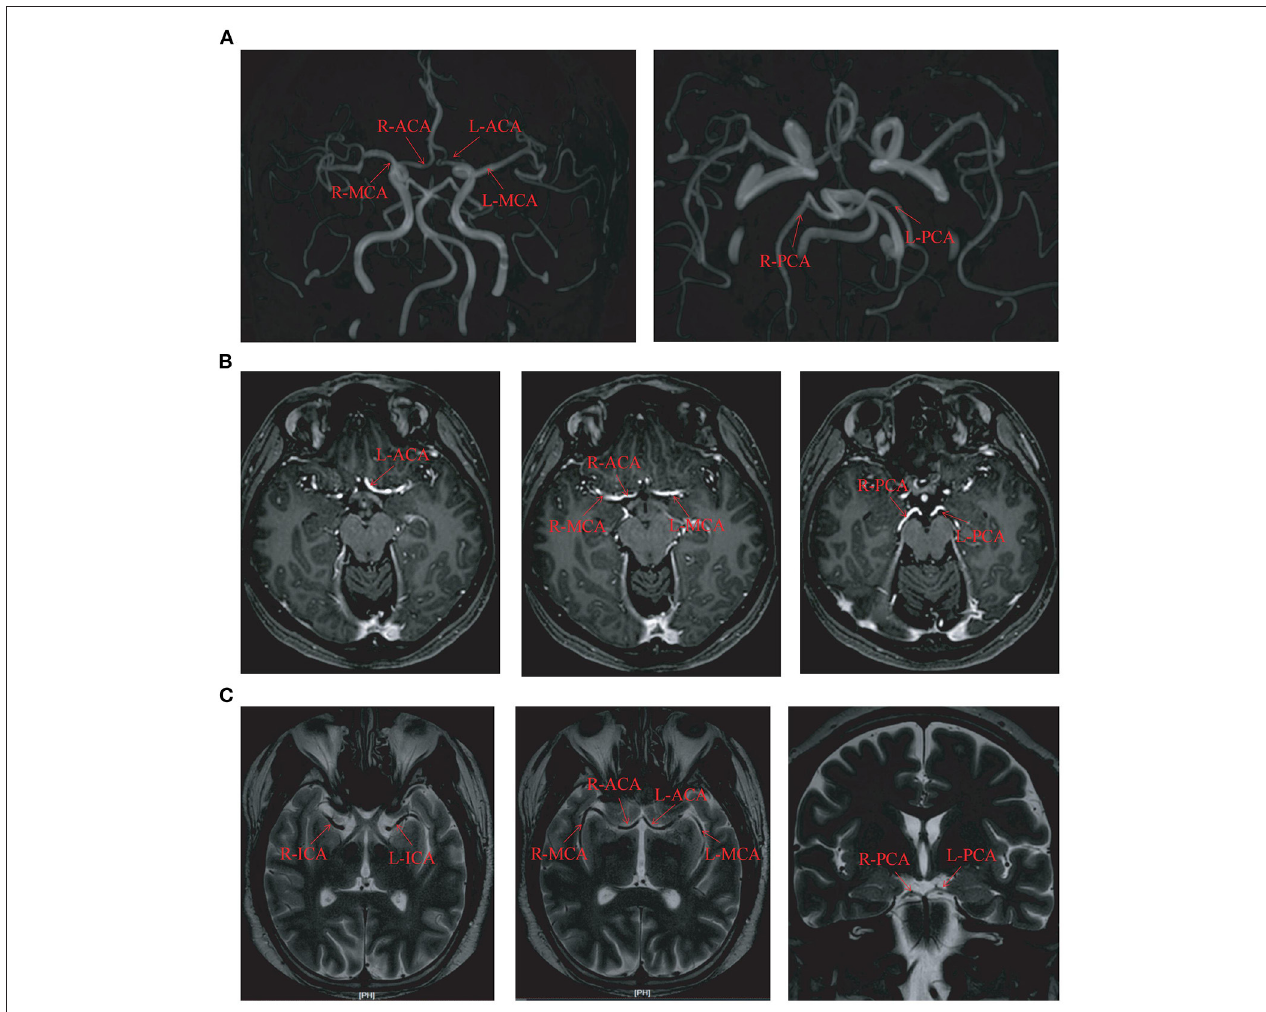
FIGURE 1 | The circle of Willis imaging in some cases. (A) The magnetic resonance angiography imaging in case number 3. (B) The hippocampal magnetic resonance imaging in case number 2. (C) The thin-layer enhanced MRI imaging in case number 15. L, left; R, right; ACA, anterior cerebral artery; MCA, middle cerebral artery; PCA, posterior cerebral artery; ICA, Internal carotid artery.